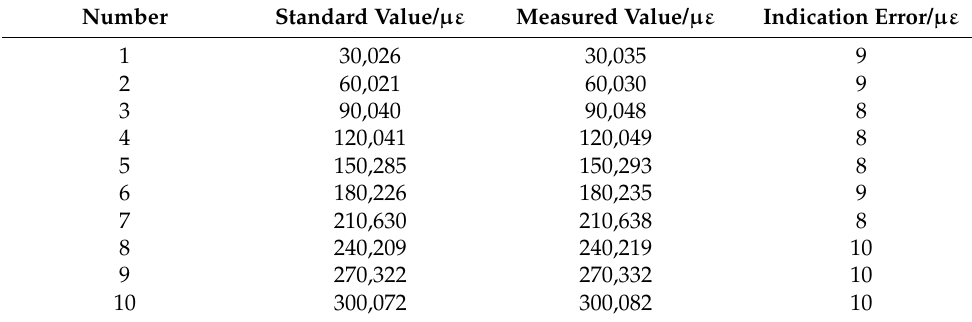
Table 5. Strain calibration results.